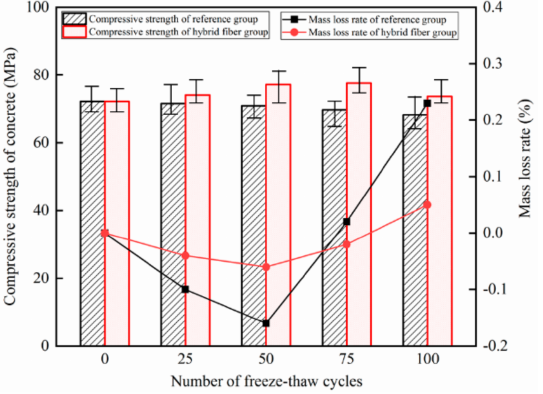
Figure 10. Relation chart of compressive strength and mass loss factors with the number of freeze– thaw